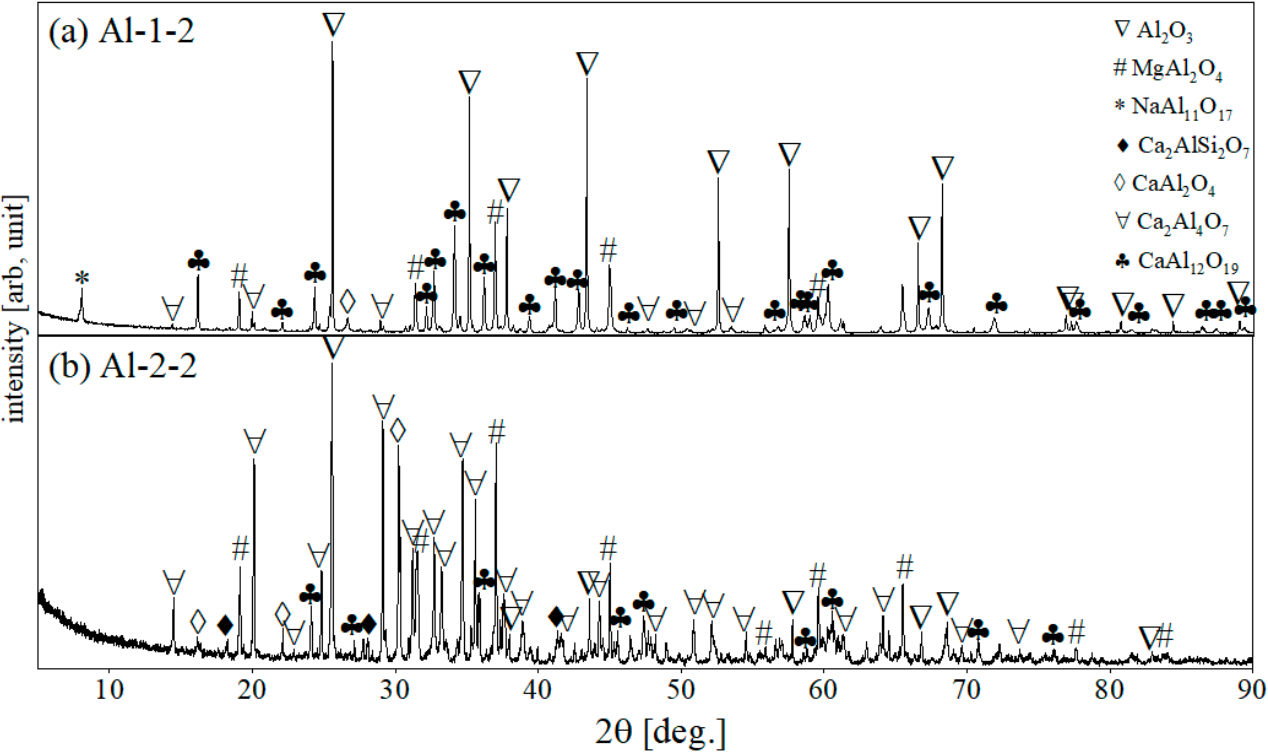
Figure 11. XRD patterns of ( a ) Al-1-2 (slag R) and ( b ) Al-2-2 samples (slag S), for 1450 °C. In both samples, calcium monoaluminate (CA), calcium dialuminate (CA 2 ), and cal- cium hexaluminate (CA 6 ) were formed. However, peaks of gehlenite (C 2 AS) were ob- served in the XRD pattern of only Al-2-2, which results from the increased silica content (10 wt.% of SiO 2 ) in slag S. (10 wt.% of SiO 2 ) in slag